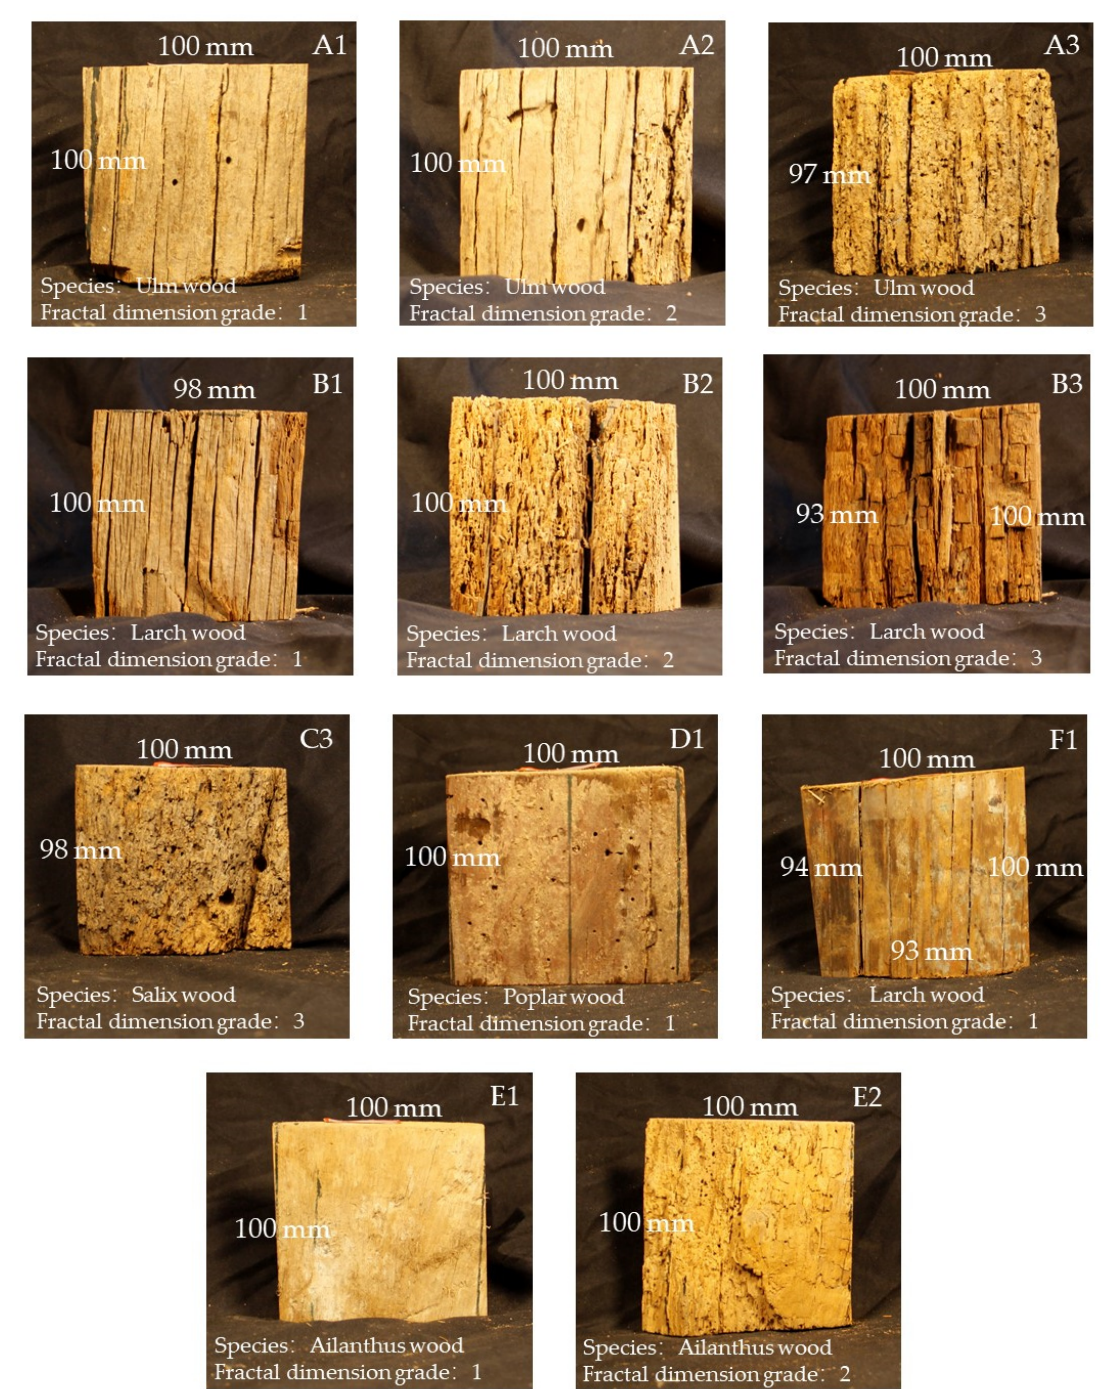
Figure 1. Sample pictures: ( A1 ) Ulm wood, fractal dimension 1.3536, grade 1, Baitai Temple, ( A2 ) Ulm wood, fractal dimension 1.4250, grade 2, Baitai Temple, ( A3 ) Ulm wood, fractal dimension 1.6211, grade 3, Baitai Temple, (B1 ) Larch wood, fractal dimension 1.2656, grade 1, Wenmiao Temple, ( B2 ) Larch wood, fractal dimension 1.5766, grade 2, Wenmiao Temple, ( B3 ) Larch wood, fractal dimension 1.6786, grade 3, Wenmiao Temple, ( C3 ) Salix wood, fractal dimension 1.7342, grade 3, Tudimiao Temple, ( D1 ) Poplar wood, fractal dimension 1.2400, grade 1, Baiyu Palace, ( E1 ) Ailanthus wood, fractal dimension 1.0575, grade 1, Dongyue Temple, ( E2 ) Ailanthus wood, fractal dimension 1.5393, grade 2, Dongyue Temple, ( F1 ) Larch wood, fractal dimension 1.3045, grade 1, Jinci